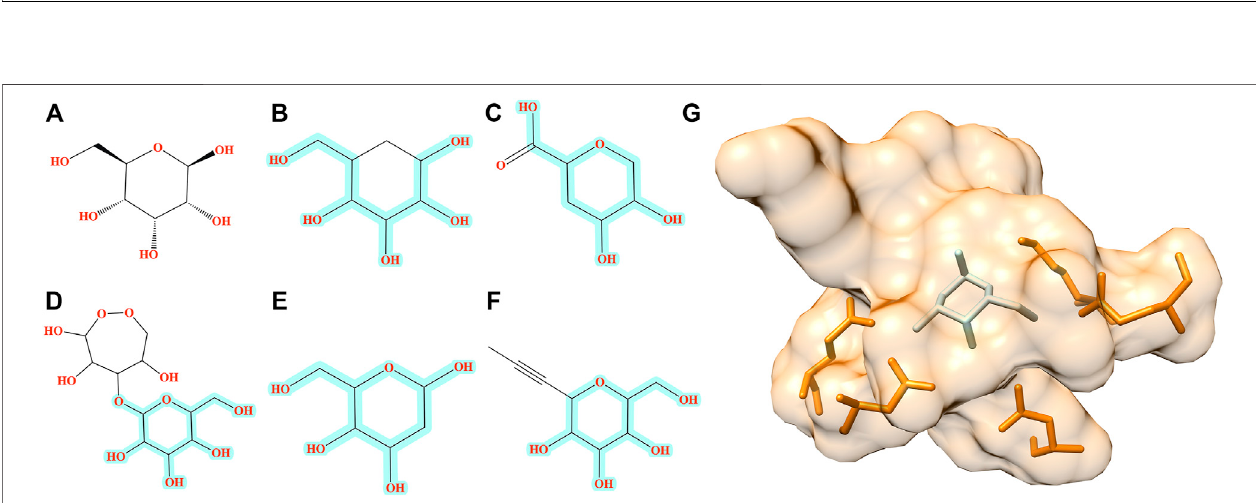
FIGURE 6 | Examples of molecules generated by Pocket2Drug for a binding site in ALBP. (A) The label ligand, ß - D -allose. (B – F) Molecules constructed by Pocket2Drug with maximum common substructures to the label ligand highlighted in cyan. (G) Molecule shown in E (ice blue) docked to the binding site in ALBP